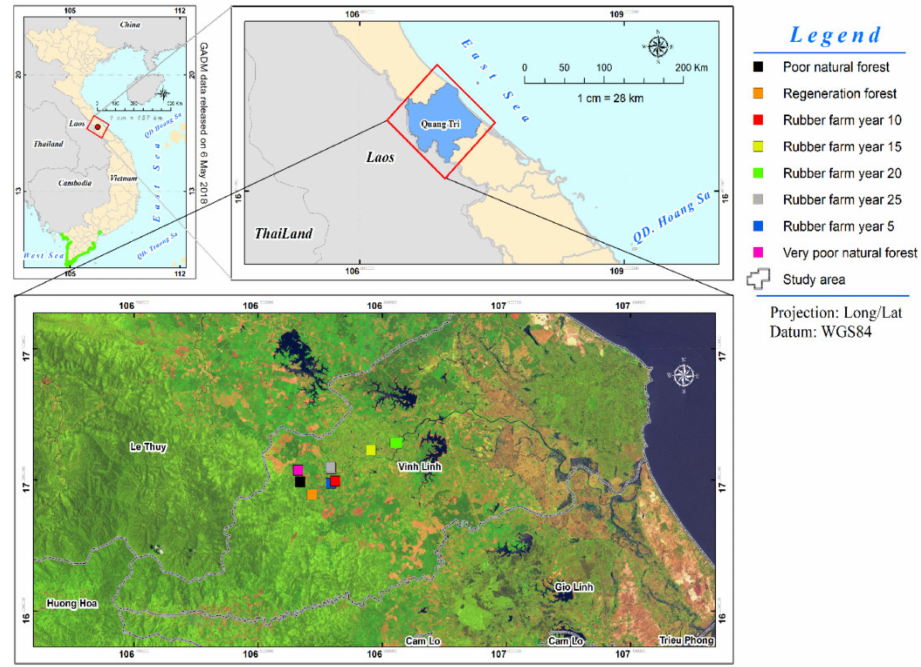
Figure 1. The location of the study area in the Vinh Linh district, Quang Tri Province,